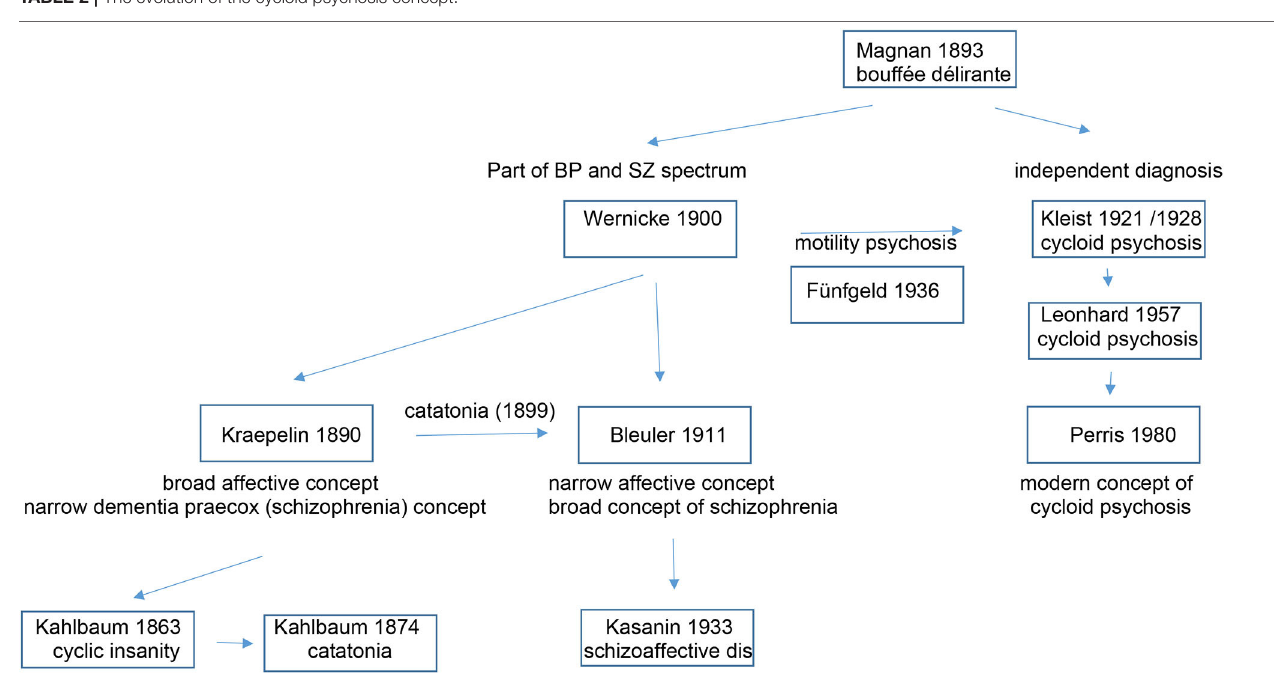
TABLE 2 | The evolution of the cycloid psychosis